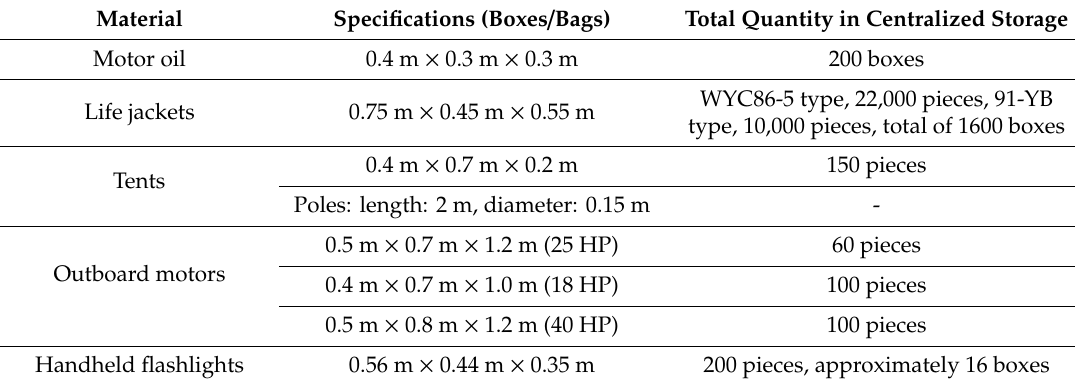
Table 3. Types, specifications, and quantities of materials in